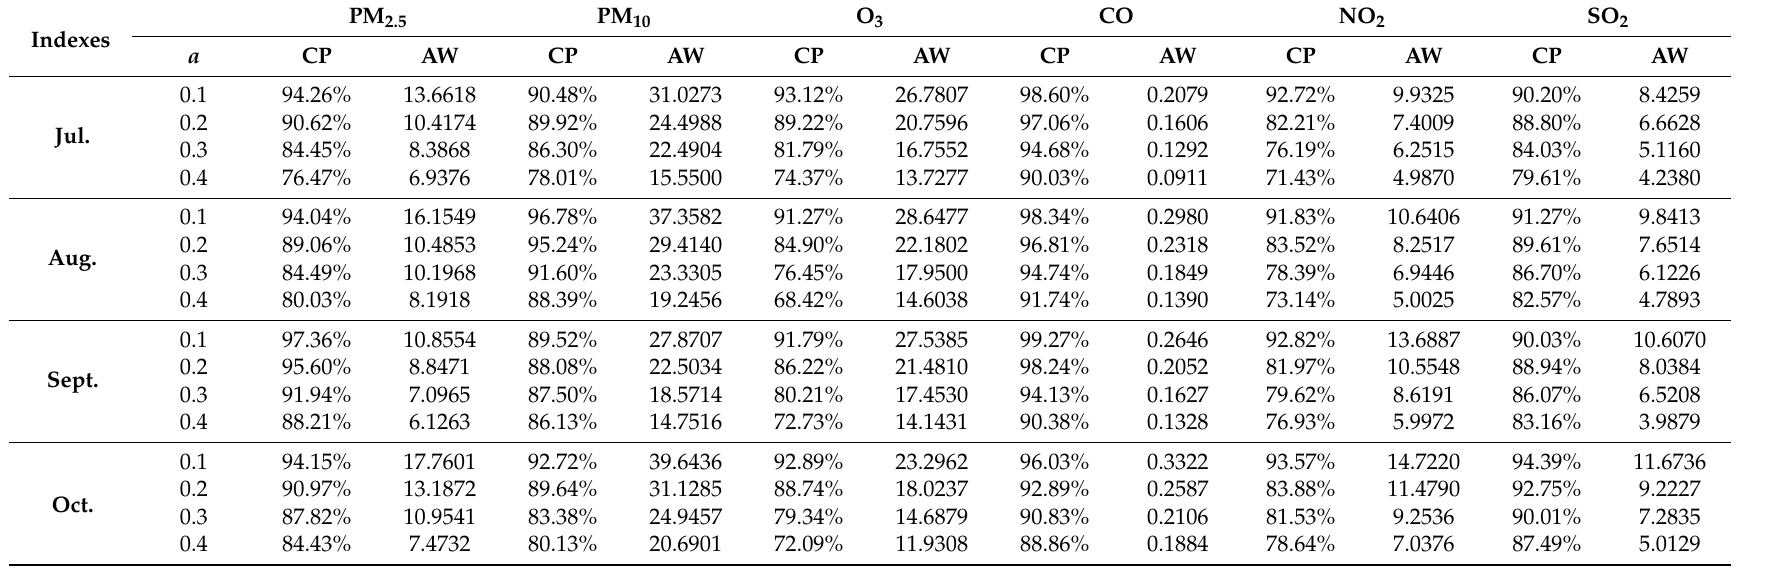
Table 9. The evaluation results of interval forecasting using CP and